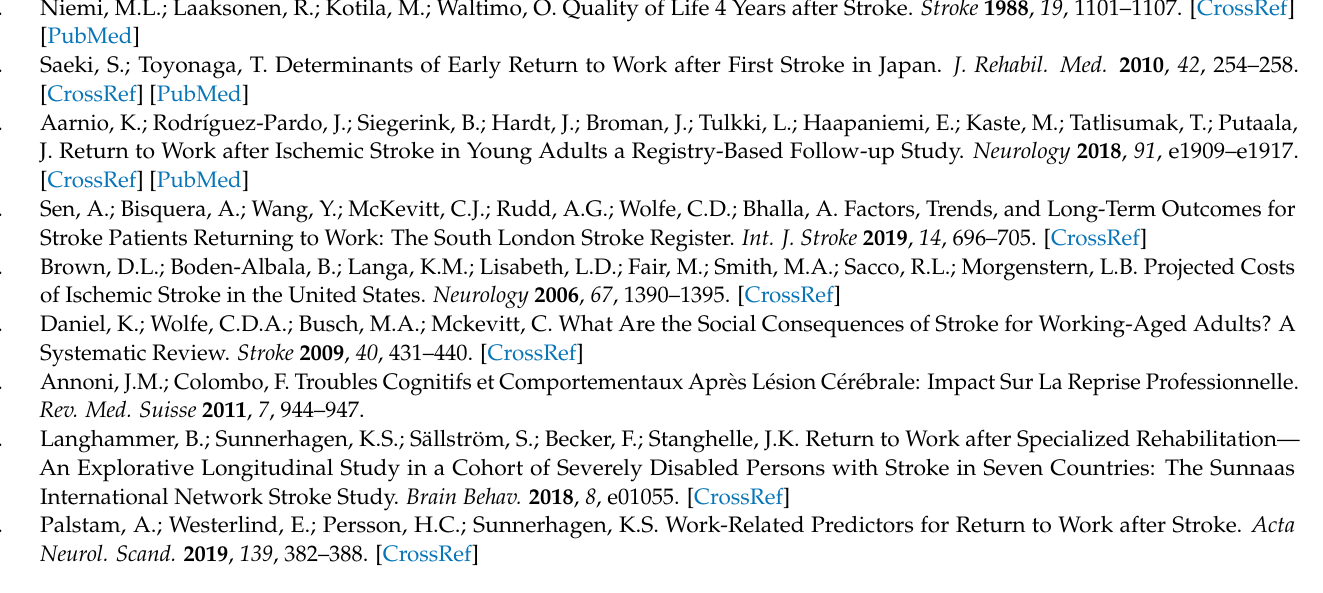
Durbin-Watson test (Assumption of independence), Table S51 Colinearity Diagnostics, Table S52 Breusch-Pagan test for heteroskedasticity, Table S53 Predicted probabilities; Causal Mediation model: Table S54 Total effect (IV –> DV), Table 255 Mediator effect (IV –> mediator), Table S56 Direct effect (IV + mediator –> DV), Table S57 Mediation analysis, Table S58 Sensitivity analysis, Figure S1 De- scriptives RTpW & Gender percentage, Figure S2 Work change in percentage, Figure S3 Discharge destination, Figure S4 Etiology TOAST, Figure S5 Gender, Figure S6 Type Of Work, Figure S7 Event Type, Figure S8 Living Situation, Figure S9 Smoking, Figure S10 Arterial Hypertension, Figure S11 Hyperlipidemia, Figure S12 Antilipid before stroke, Figure S13 Antilipid at discharge, Figure S14 Le- sion Site, Figure S15 Thyroid-Stimulating Hormone, Figure S16 Duration hospitalization, Figure S17 Age, Figure S18 BMI, Figure S19 LDL-Cholesterol, Figure S20 Total Cholesterol, Figure S21 NIHSS, Figure S22 Montreal Cognitive Assessment (MoCA), Figure S23 Hospital Anxiety and Depression scale (HAD), Figure S24 Fatigue Impact Scale (FIS) Cognitive, Figure S25 FIS Physical, Figure S26 FIS Psychosocial, Figure S27 ROC Curve, Figure S28 Number of months needed to RTpW, Figure S29 Assumption of heteroscedasticity, Figure S30 Sensitivity